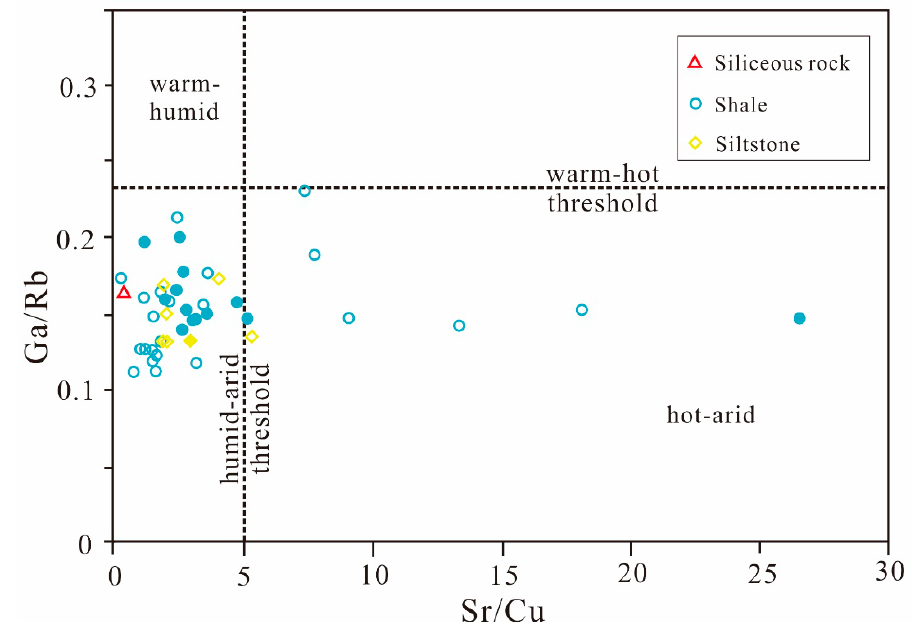
Figure 16. Cross plot of Sr/Cu vs. Ga/Rb ratios showing paleoclimatic conditions. Hollow points are the samples from SQ-1 and solid points are the samples from